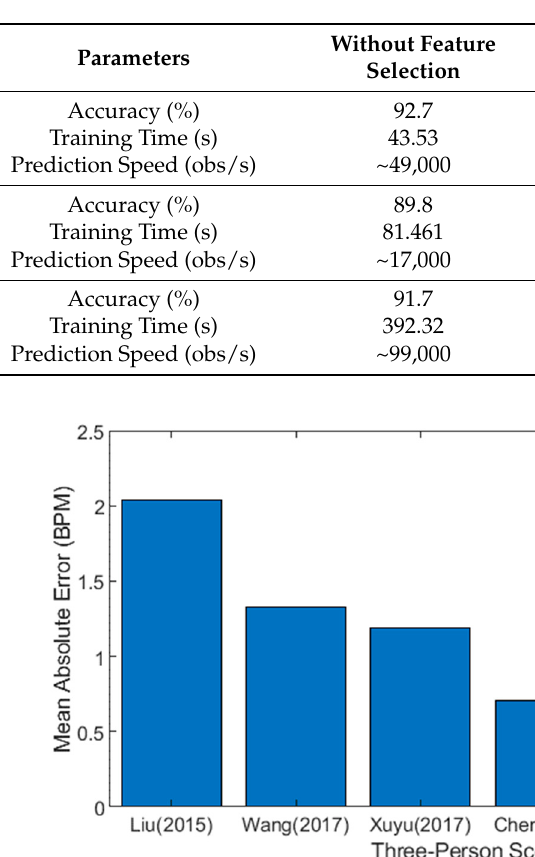
Table 4. Multi-persons scenario.